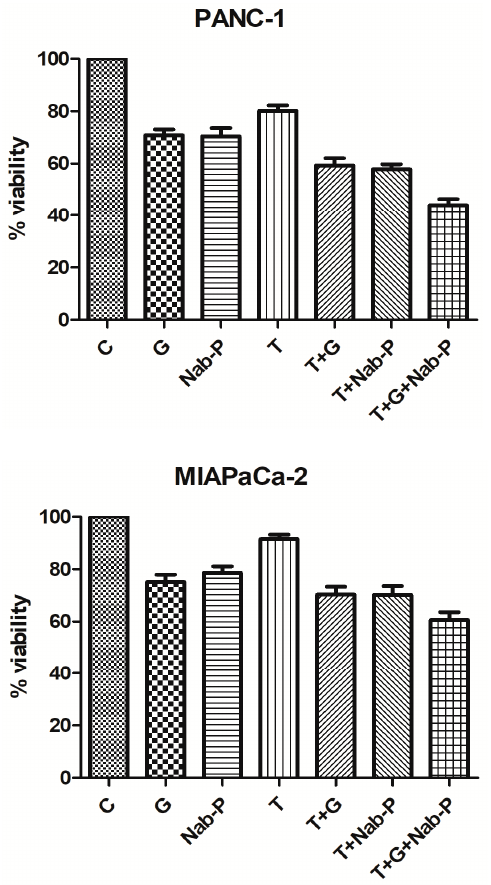
Figure 1. Tinzaparin administration with drug combinations results in further decrease in cell via- bility. Cell viability with XTT assay of the mutant KRAS pancreatic cancer cell lines PANC-1 and MIAPaCa-2 after 48 h treatment with 1 μ M Nab-paclitaxel (Nab-P), 1 μ M gemcitabine (G) and 2 UI/mL tinzaparin (T) alone or in combination. All data represent mean ± SD and three independent